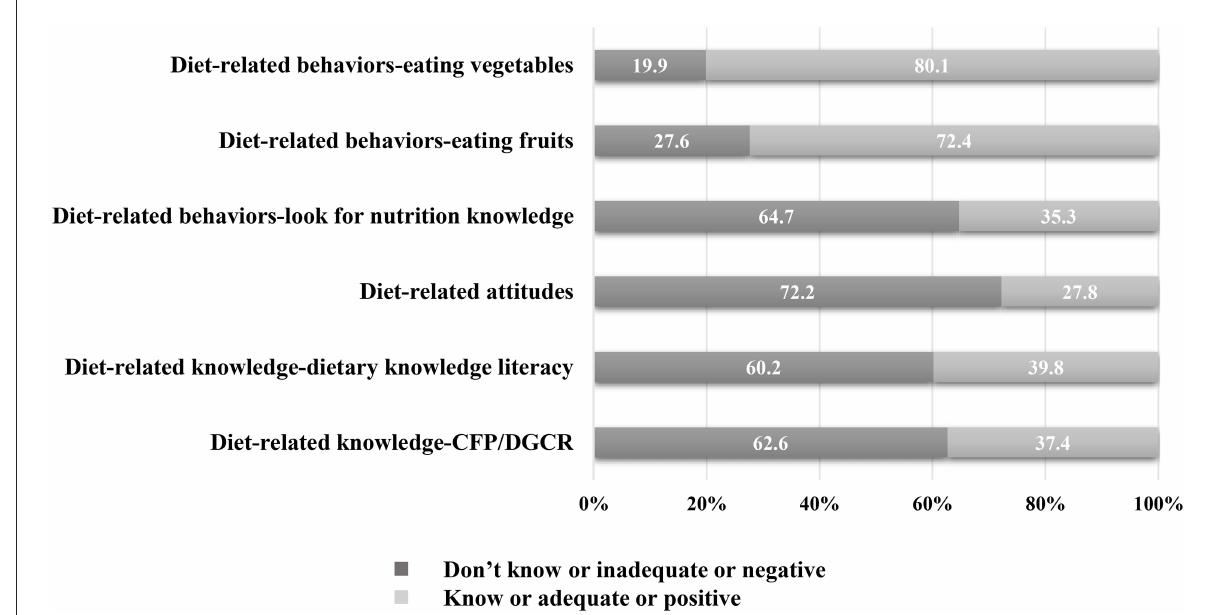
FIGURE2 Percentage of diet-related knowledge, attitudes, and behaviors among participant with high-normal blood pressure. CFP, Chinese Food Pagoda; DGCR, the Dietary Guidelines for Chinese Residents.